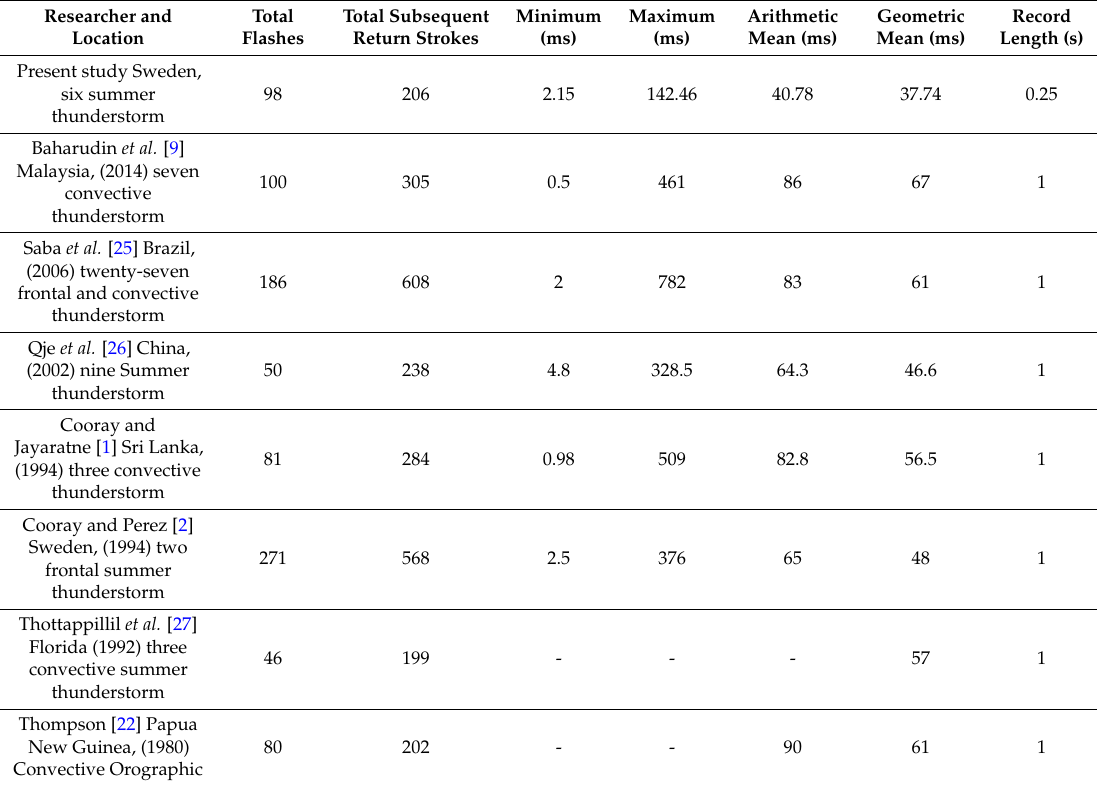
Table 5. Inter-stroke interval for Subsequent Return Strokes